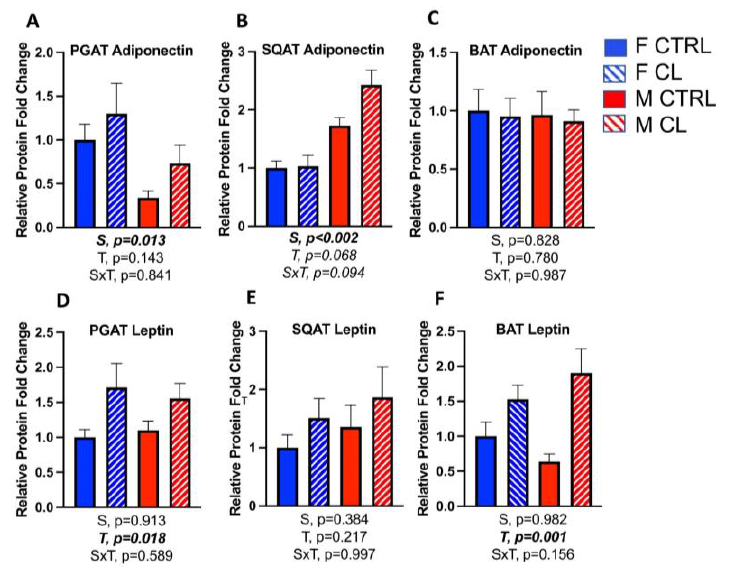
Figure 7. Male (M) and female (F) C57BL/6J mice, all on HFD, were treated for 2 weeks with daily CL injections (1 μg/g body weight) or CTRL (saline). Perigonadal (PGAT), subcutaneous (SQAT) and brown (BAT) adipose tissue depots were collected, and the protein of adipokines was measured via Western blotting. ( A ) PGAT adiponectin; ( B ) SQAT adiponectin; ( C ) BAT adiponectin; ( D ) PGAT leptin; ( E ) SQAT leptin; ( F ) BAT leptin. All data are presented as mean ± SEM, relative to the F CTRL. N = 7–9/group. Main effects of sex (S), CL treatment (T) and sex by treatment interactions (S×T) were determined by 2 × 2 ANOVA and are presented below the respective figures. p -values < 0.05 were accepted as significant.